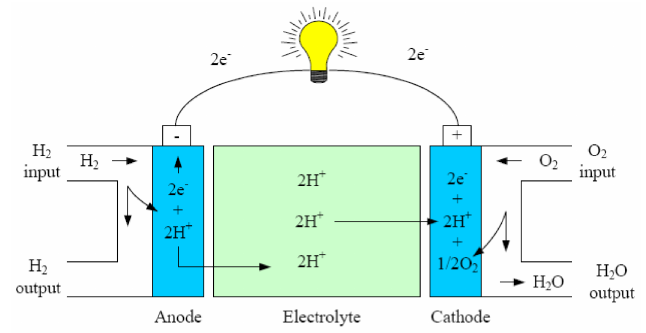
Figure 2. PEM-FC principles of